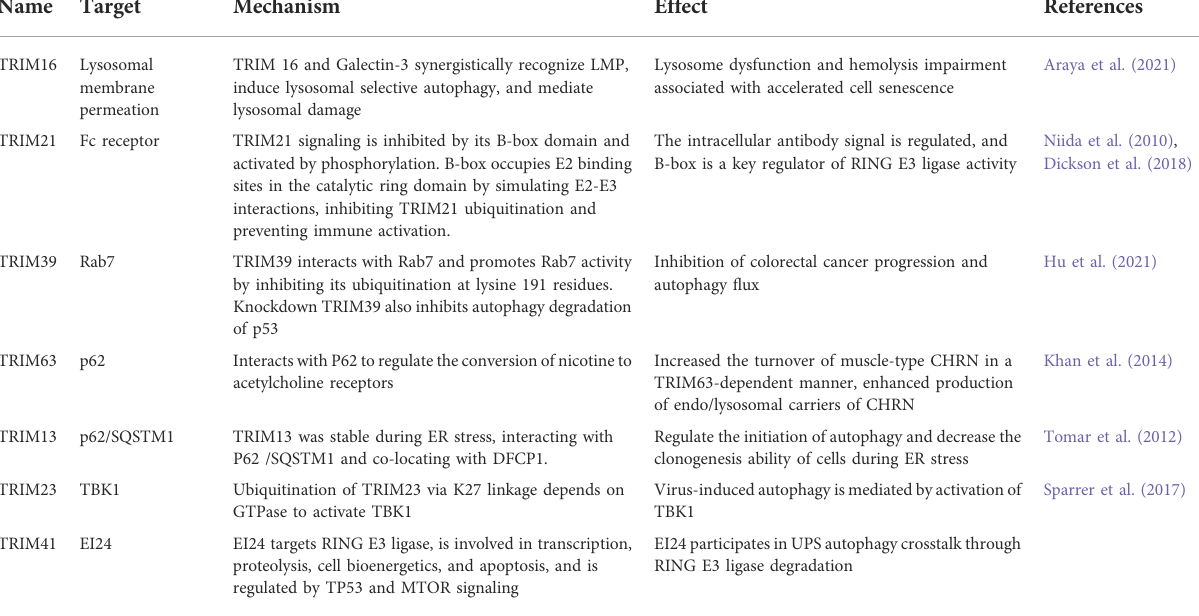
TABLE 5 Relationship between TRIMs and